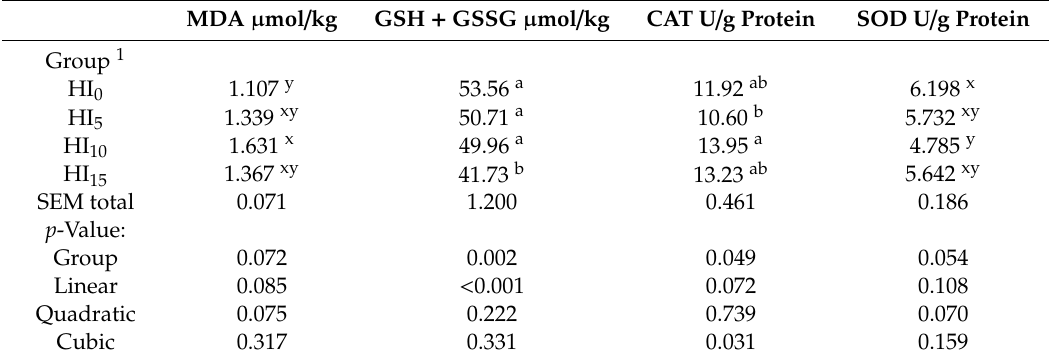
Table 6. Redox status of the liver of turkeys.